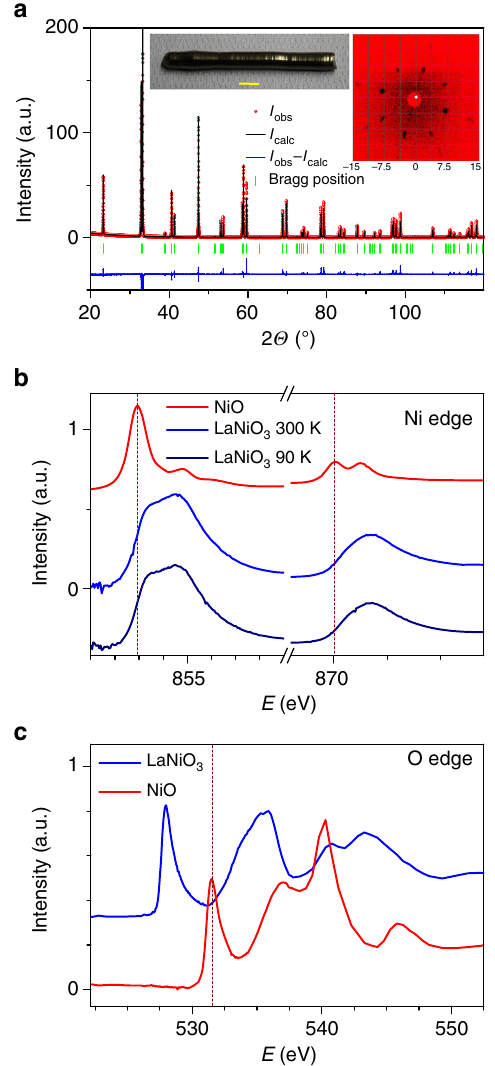
Fig. 1 Characterization of LaNiO 3 . a Powder X-ray diffraction pattern of a powdered LaNiO 3 single crystal. The inset shows a photo of the LaNiO 3 single crystal and its Laue diffraction pattern. A length scale of 1 cm is indicated by the yellow bar within the photo of the crystal and the distance between two lines in the Laue pattern amounts to 3.75 cm. b The Ni-L 2,3 XAS spectra of the LaNiO 3 single crystal measured at 90 and 300 K together with the spectrum of a NiO reference compound. c The O-K XAS spectra of our LaNiO 3 single crystal measured at 300 K (blue line) together with the spectra of the NiO reference compound (red